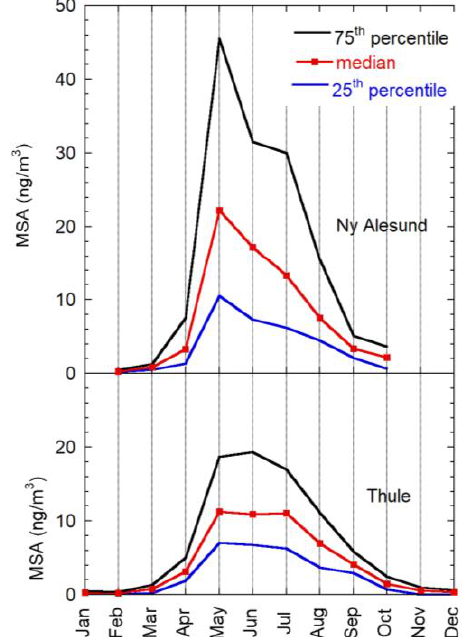
Figure 2. Methanesulfonic acid (MSA) time series at Ny Ålesund and Thule. Red lines represent high resolution data (24 h at Ny Ålesund, 48 h at Thule), blue lines are monthly mean values.